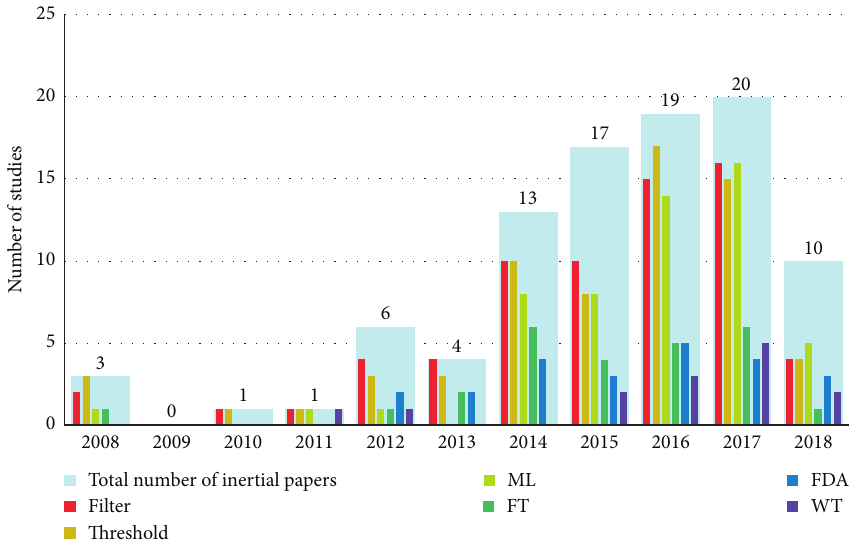
Figure 7: The most referred methods and annual